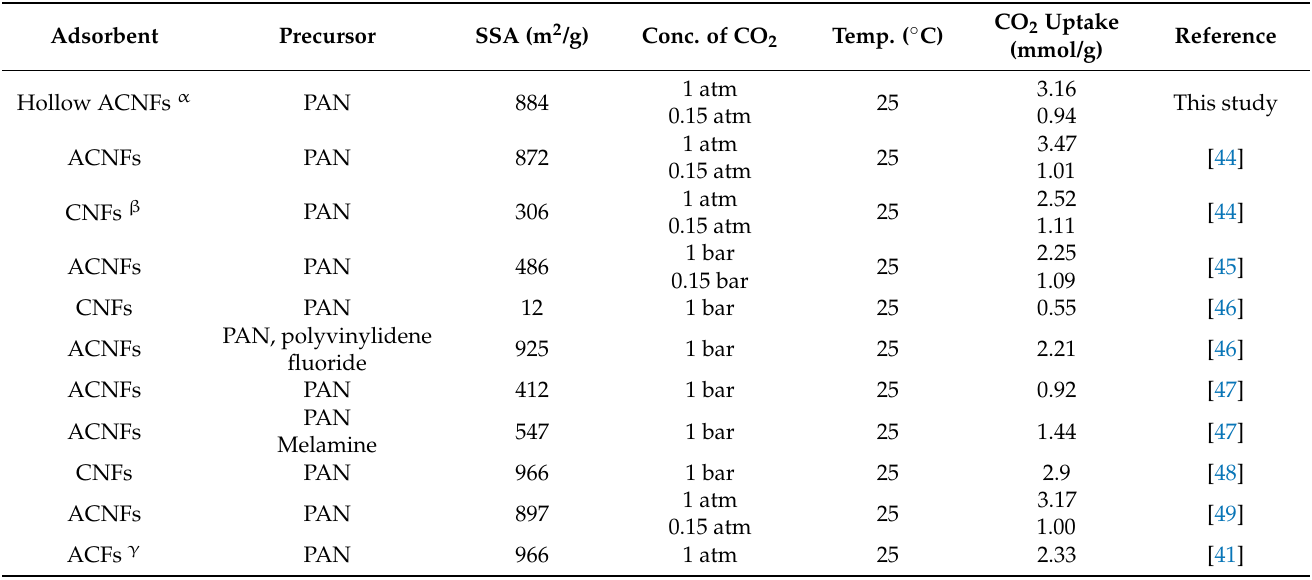
Figure 8. The isosteric heat of adsorption of CO 2 on the samples. Table 3. Comparisons of CO 2 uptakes on the adsorbents in this study with various support materials using electrospinning in the